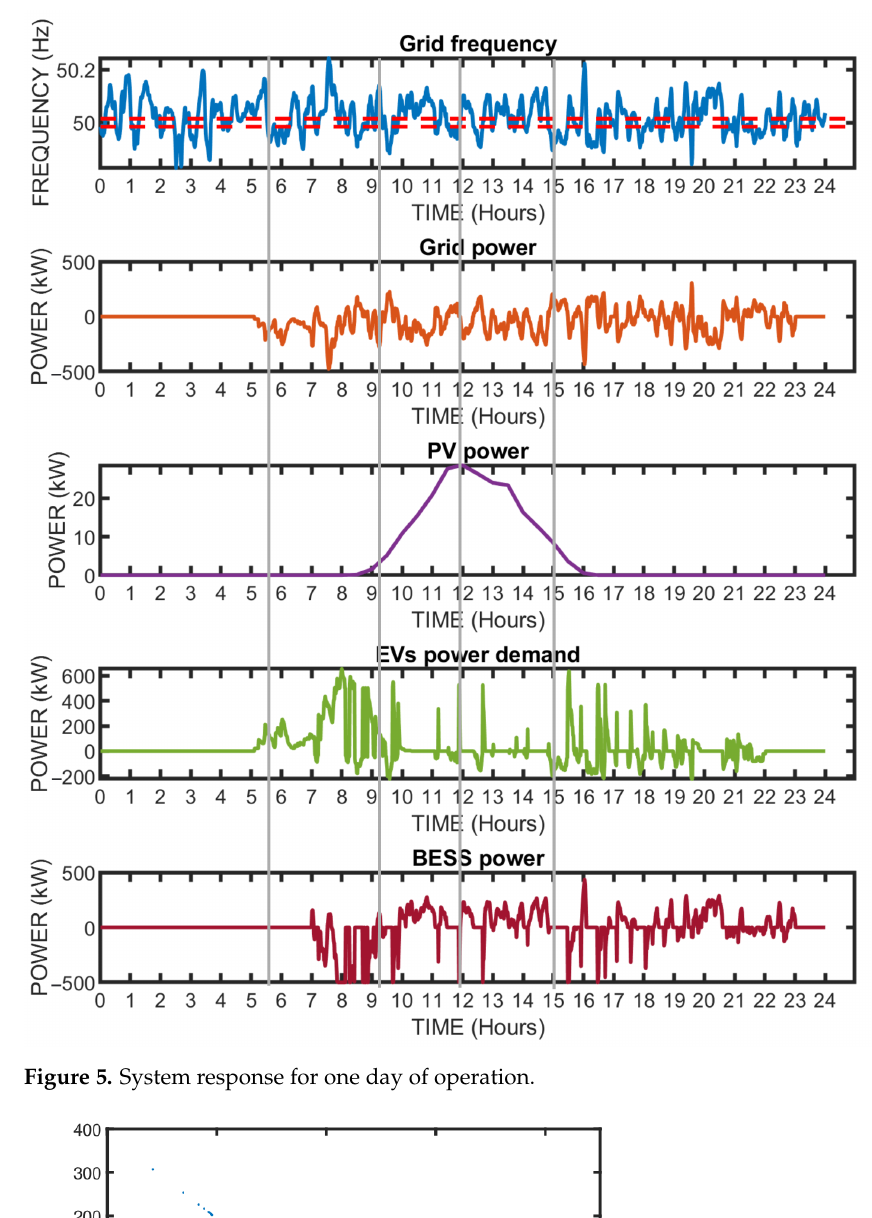
Figure 5. System response for one day of operation.